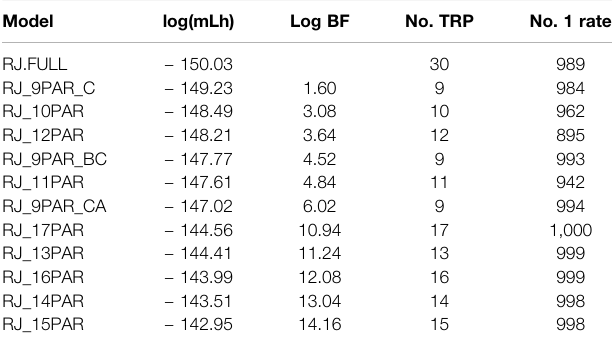
TABLE 1 | Performance of the RJ models, ordered by log mLh. log BFs are calculatedforeachrowusing2(logmLhcurrentmodel − logmLhRJ.FULL).no.